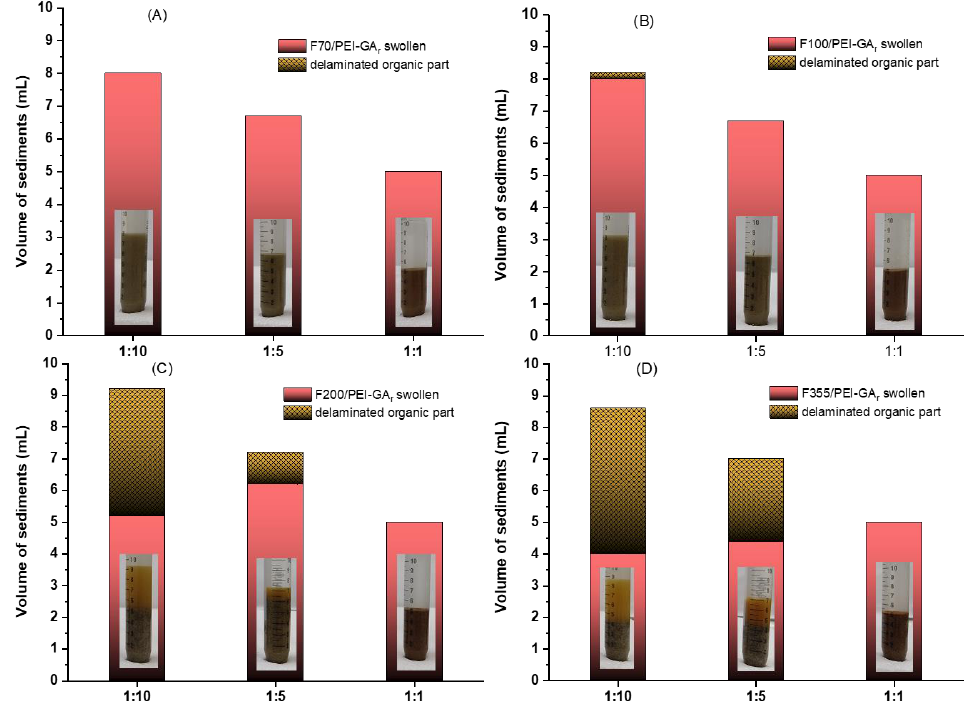
Figure 2. Volume of composite sediments for each functionalized sand fraction (( A ) = F70, ( B ) = F100, ( C ) = F200 and ( D ) = F355) as a function of the cross-linking degree (r = 1:10, 1:5 and 1:1) measured after strong base and acid treatment.